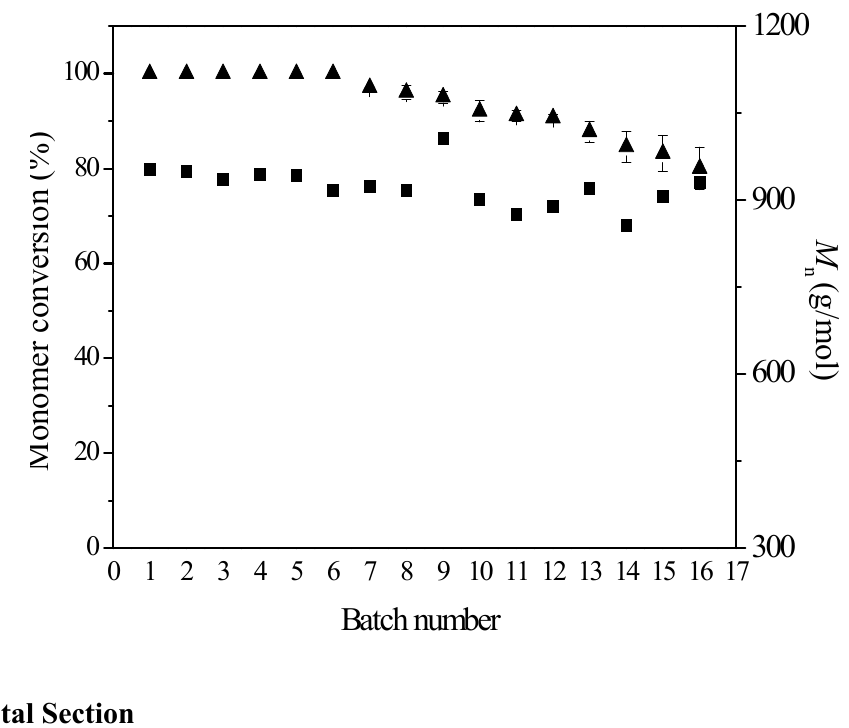
Figure 4. Monomer conversion and M values for a series of consecutive batch reactions n conducted using 60 mg immobilized enzyme as catalyst; on completion of one reaction, the catalyst was washed and recycled for use in the next. The reactions were carried out using 60 mg immobilized enzymes, 200 μ L ε -caprolactone and 600 μ L toluene at 80 °C for 72